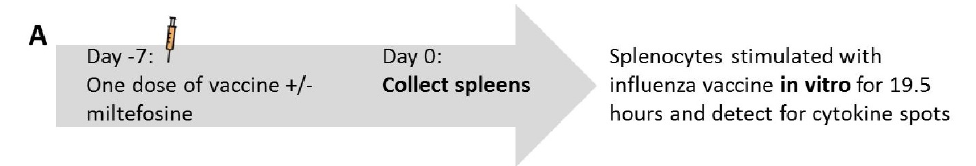
Figure 5. The antigen-specific cytokine responses of the splenocytes upon in vitro antigen recall. Spleens were harvested from mice 7 days after received a single dose of vaccine with or without miltefosine, and splenocytes were stimulated in vitro with the influenza vaccine for 19.5 h. ( A ) Schedule of influenza vaccine and spleen sample collection. ( B ) Number of IFN- γ secreting cells (left) and IL-4 secreting cells (right). MTF-VAC, miltefosine (0.2 mg) + vaccine group; VAC, vaccine only group; MTF, miltefosine (0.2 mg) only group; PBS, PBS only group. Data collected from 5–6 mice per group (2 independent experiments). * for p < 0.05; ** for p < 0.01; **** for p < 0.0001; calculated by two- way ANOVA followed by a Tukey’s multiple comparison test. Error bar indicates standard error of mean (SEM). 4. Discussion The effectiveness of the influenza vaccine is suboptimal. Vaccine adjuvant has been used in boosting the immune response. In this study, we have found that MTF, an FDA-approved anti- leishmaniasis drug, significantly improved the protective efficacy of influenza vaccines. After the lethal challenge of A(H1N1) virus, the MTF-VAC group had a significantly higher survival rate than the VAC group. The improved survival in the adjuvanted group occurred as soon as 3 days after vaccination, and was accompanied by an accelerated and augmented antibody response, and a more robust T FH cell response. Both T H 1 and T H 2 responses were stimulated. Furthermore, we have demonstrated that the MTF-adjuvanted vaccine induced a better antibody response against antigenically-drifted influenza viruses within the same subtype. Generally, influenza vaccine studies assess the protective efficacy after at least two doses and at least 4 weeks after vaccination [35–38]. However, given the delayed availability of vaccines, patients would benefit from an early effect of vaccination. We assessed the early protective effect of the imiquimod-adjuvanted influenza vaccine previously [13,14]. In this study, we demonstrated an improved survival rate even when the mice were vaccinated as little as 3 days before infection. This quick onset of protection made MTF-adjuvanted influenza vaccine more potent in prevention of epidemic spreading. The improved antibody response in the MTF-VAC group was associated with a more robust T FH response and a more potent germinal center reaction. This is in contrast with our previous study on the TLR7 agonist, imiquimod, in which there was no difference in the GC reaction between the imiquimod-adjuvanted group and non-adjuvanted group [27]. T FH cell is the key T cell subtype that interacts with B cells in lymphoid follicles [39]. T FH cells are derived from CD4 + T cells in the T cell zone after being primed by dendritic cells. These T FH cells migrate to the B cell zone and interact with B cells, promoting B cell differentiation into plasma cells and memory B cells [40]. T FH cells secrete IL- 21 to induce B cell activation, proliferation and differentiation. T FH cells also express the costimulatory molecule CD40L for B cell survival. These interactions form the basis of GC reaction which can be seen in our MTF-VAC group. Live-attenuated influenza virus vaccine induced elevated